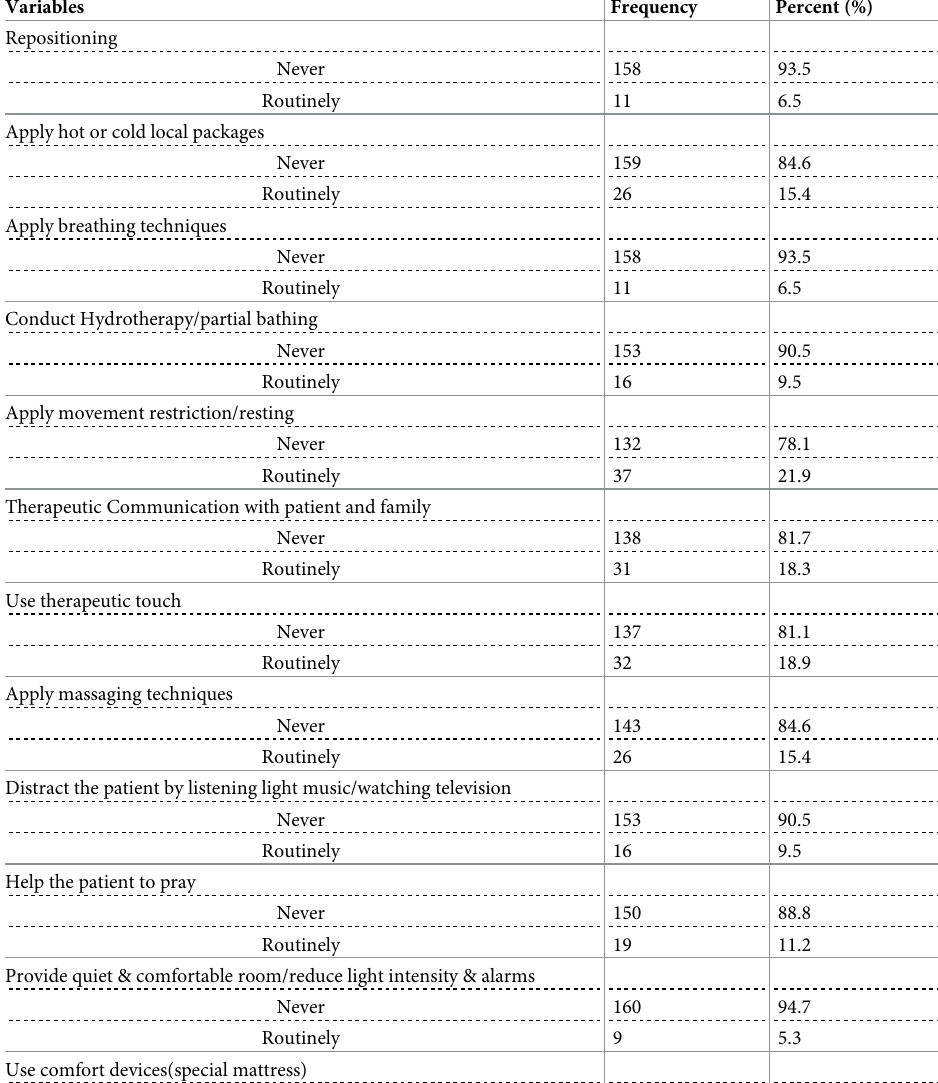
Table 2. Non-pharmacological pain management method utilization by nurses working in Debre Tabor Compre- hensive Specialized Hospital, Ethiopia,